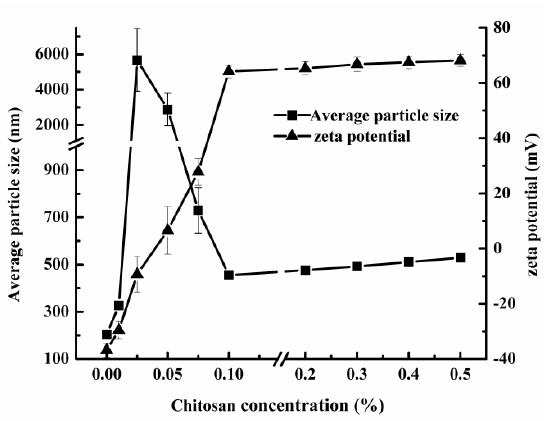
Figure 4. Effect of chitosan concentration on average particle size and zeta potential of secondary emulsion.